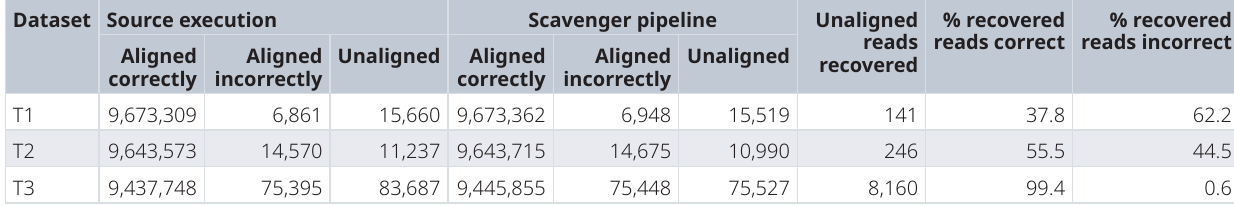
Table 3. Alignment statistics for simulated datasets before and after Scavenger recovery using optimised parameters for STAR.